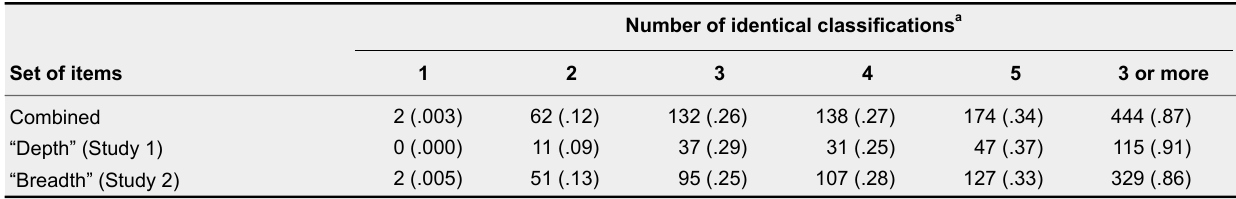
Consistency of Participants’ Classifications of Content Into Hypotheses (From the Over-Arching Set of 6 Candidates) in Study 2